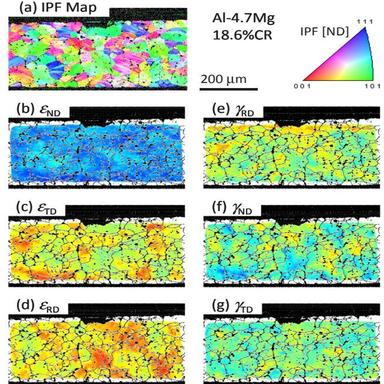
Comparison of strain components distribution with microstructure obtained by SEM/EBSD on a cross-section of the SRCT scanned sample in Al-4.7mass%Mg alloy after 18.6% cold rolling.